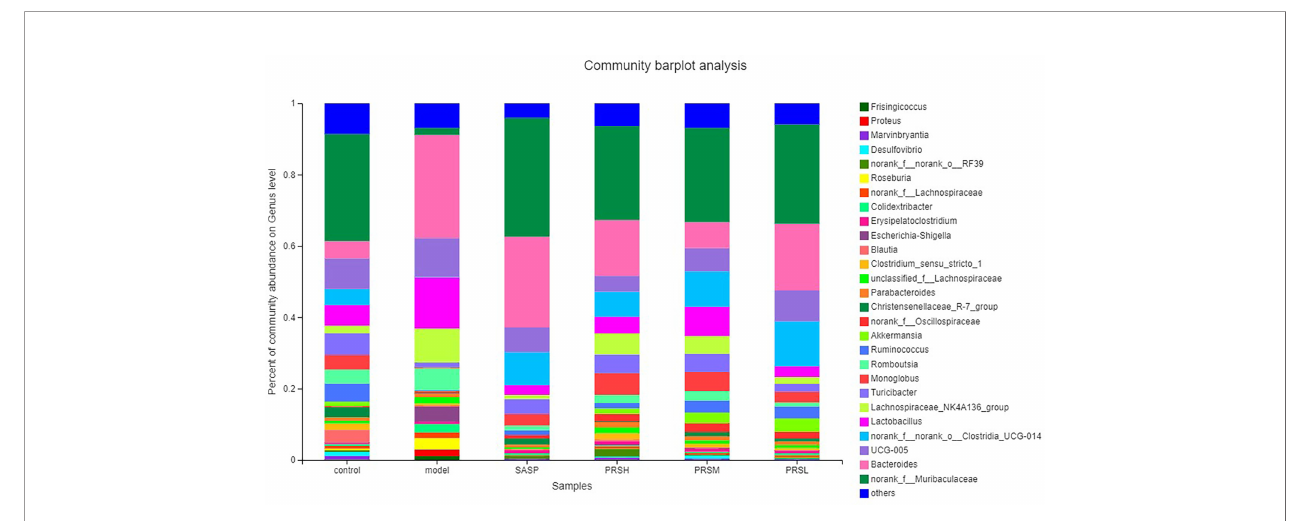
FIGURE 12 | Community barplot analysis on genus